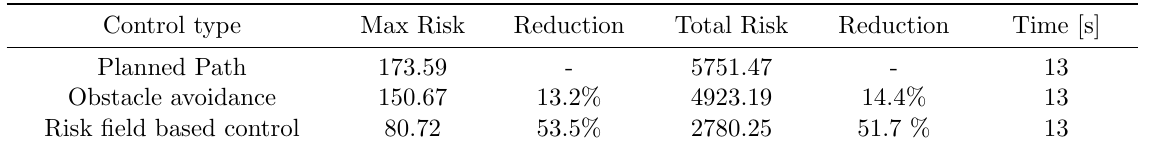
Table 3: Priority for Risk Reducing Measures